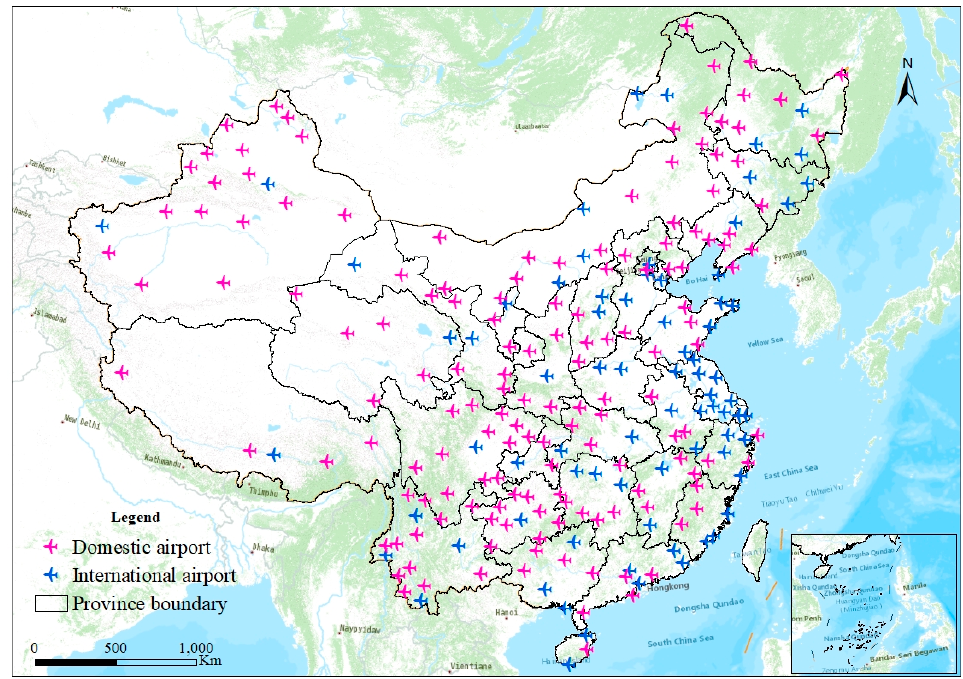
Figure 1. Spatial distribution of civilian airports in China.